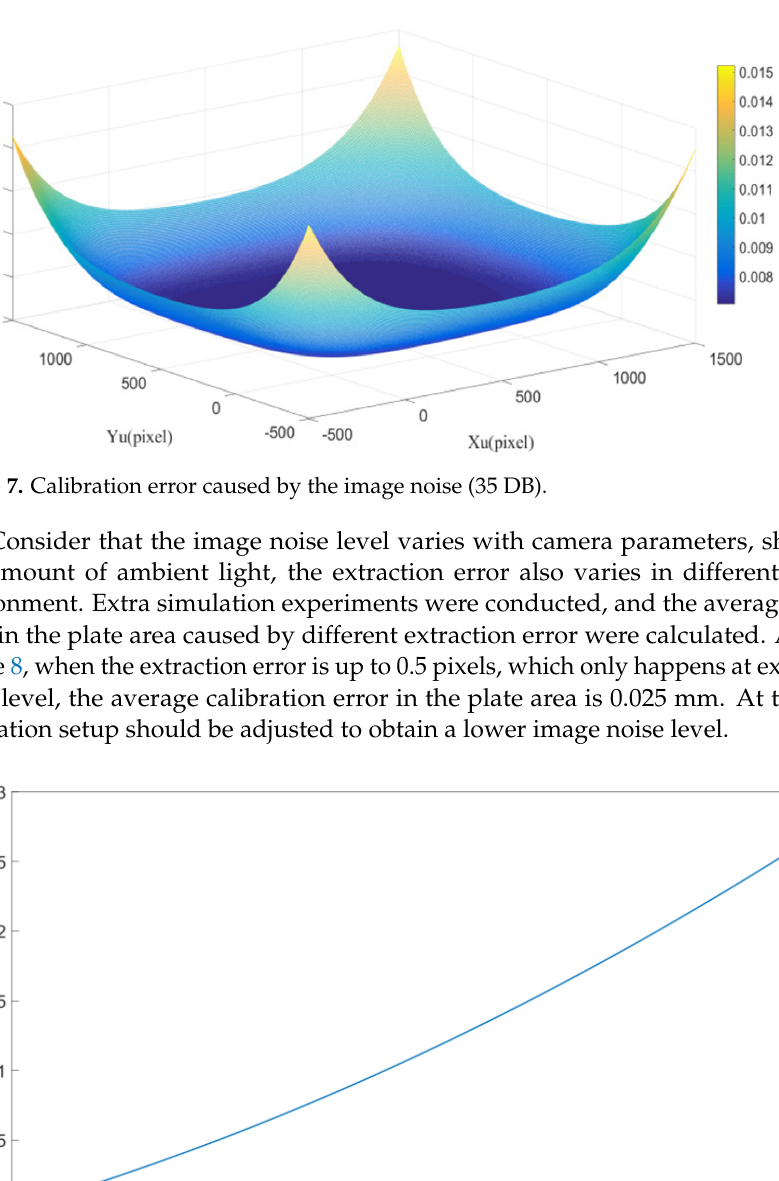
Figure 8. Mean calibration error in the plate area with different extraction error.